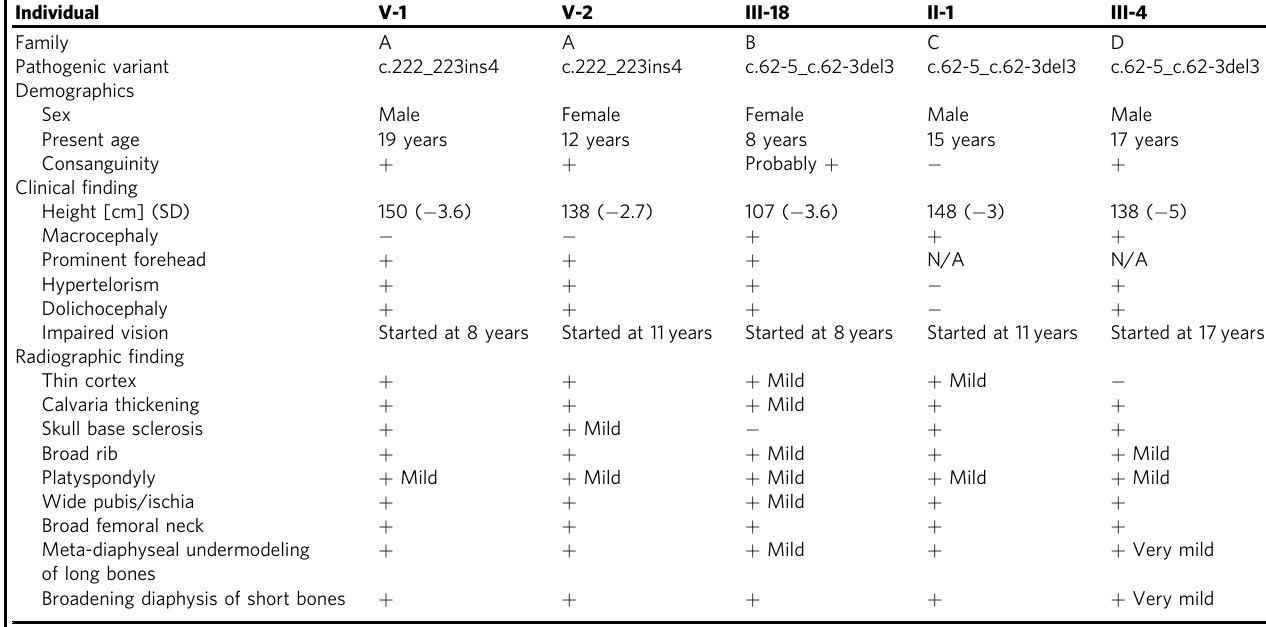
Table 1 Clinical and radiographic fi ndings of the four Indian families with homozygous TMEM53 pathogenic variants.